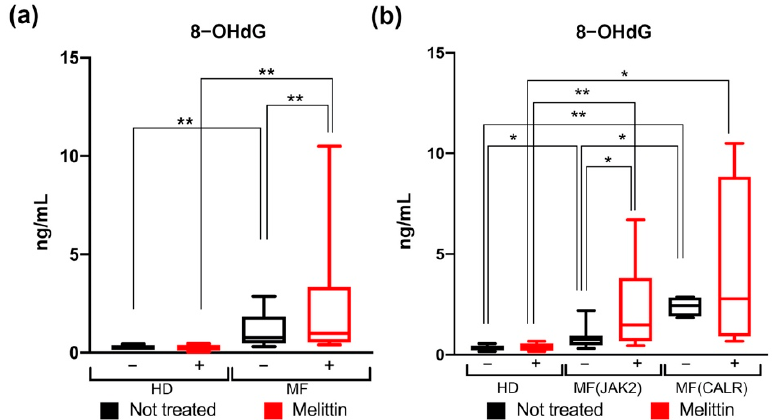
Figure 3. Measurement of 8-OHdG levels in CD34+ cells of MF patients. ( a ) Box plot shows the 8- OHdG levels in HD and in MF samples, with (red bars) or without (black bars) 24 h Melittin treatment respectively. ( b ) Box plot shows the levels of 8-OHdG in JAK2- or CALR -mutated MF patients compared to HD, with (red bars) or without (black bars) 24 h of Melittin treatment respectively. Data are reported as median of 8-OHdG levels (expressed in ng/mL) with 95% CI (confidence interval). The comparisons between HD and MF were analyzed by means of Mann–Whitney U test, while the comparisons between treated and not treated cells were analyzed using Wilcoxon matched-pairs signed rank test. * p < 0.05, ** p <